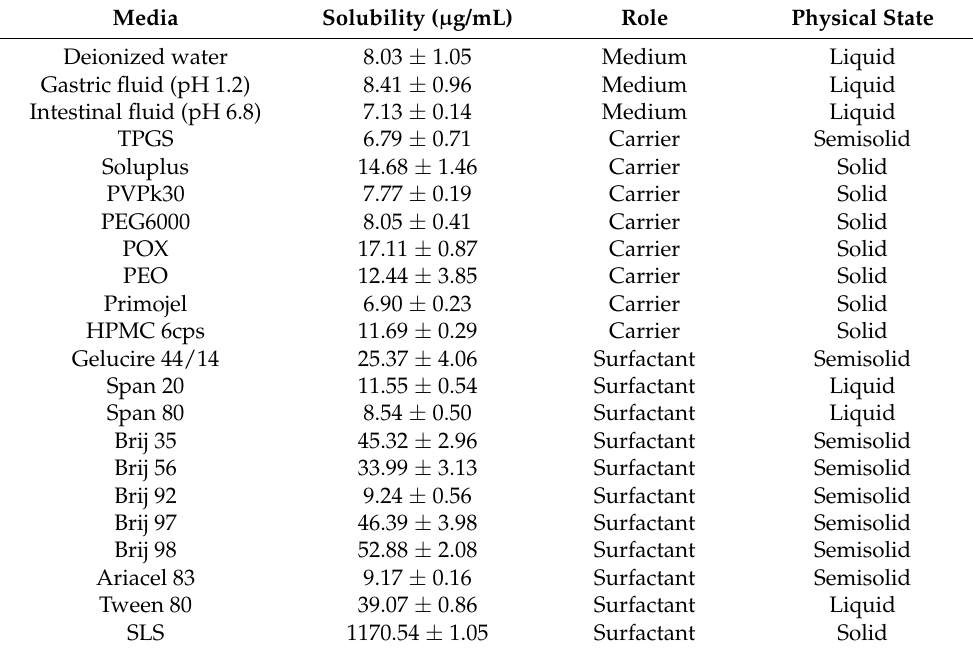
Table 2. Solubility of CLT in distilled water, different pH buffers, and 1% w/v aqueous solutions of various